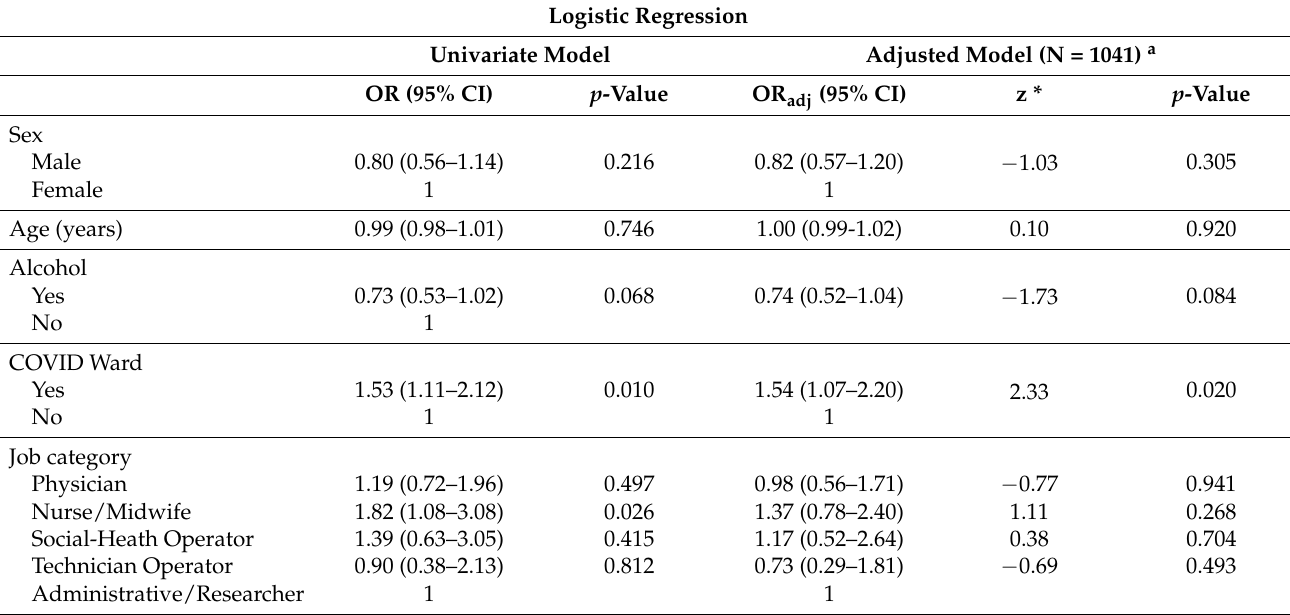
Table 2. Logistic Regression